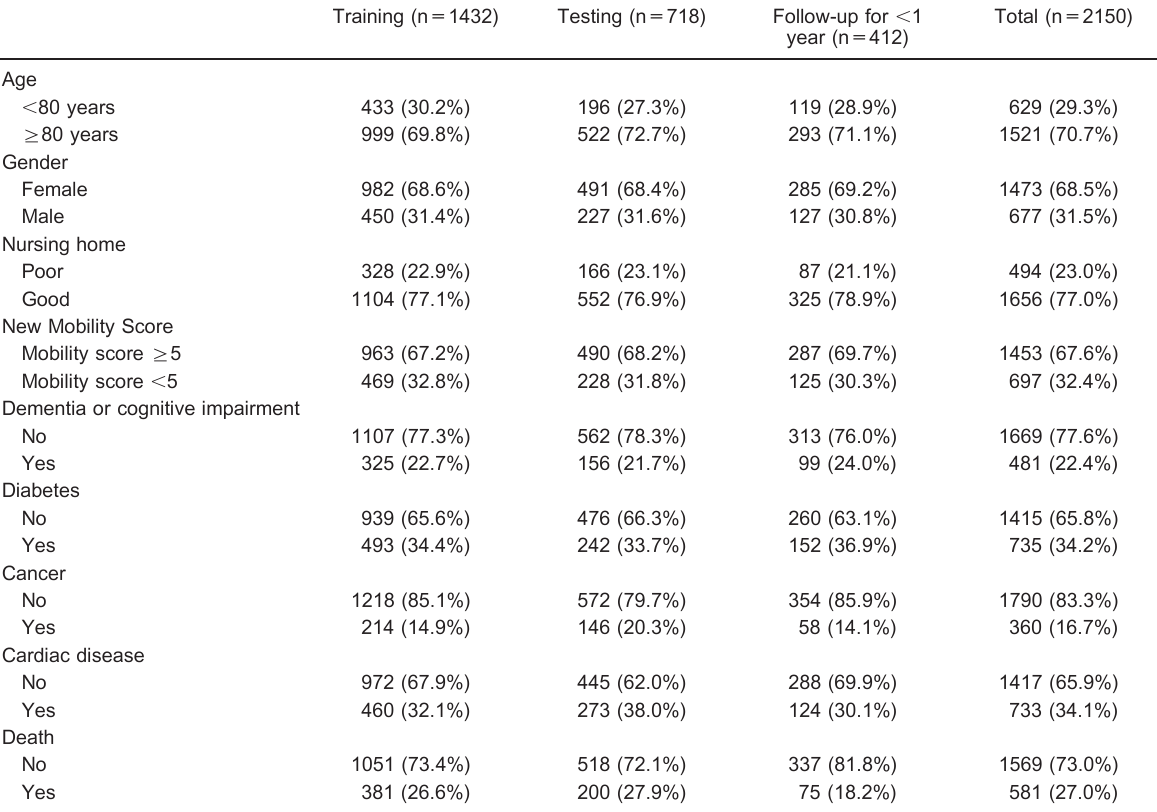
There were no significant differences between variables ( t -test).